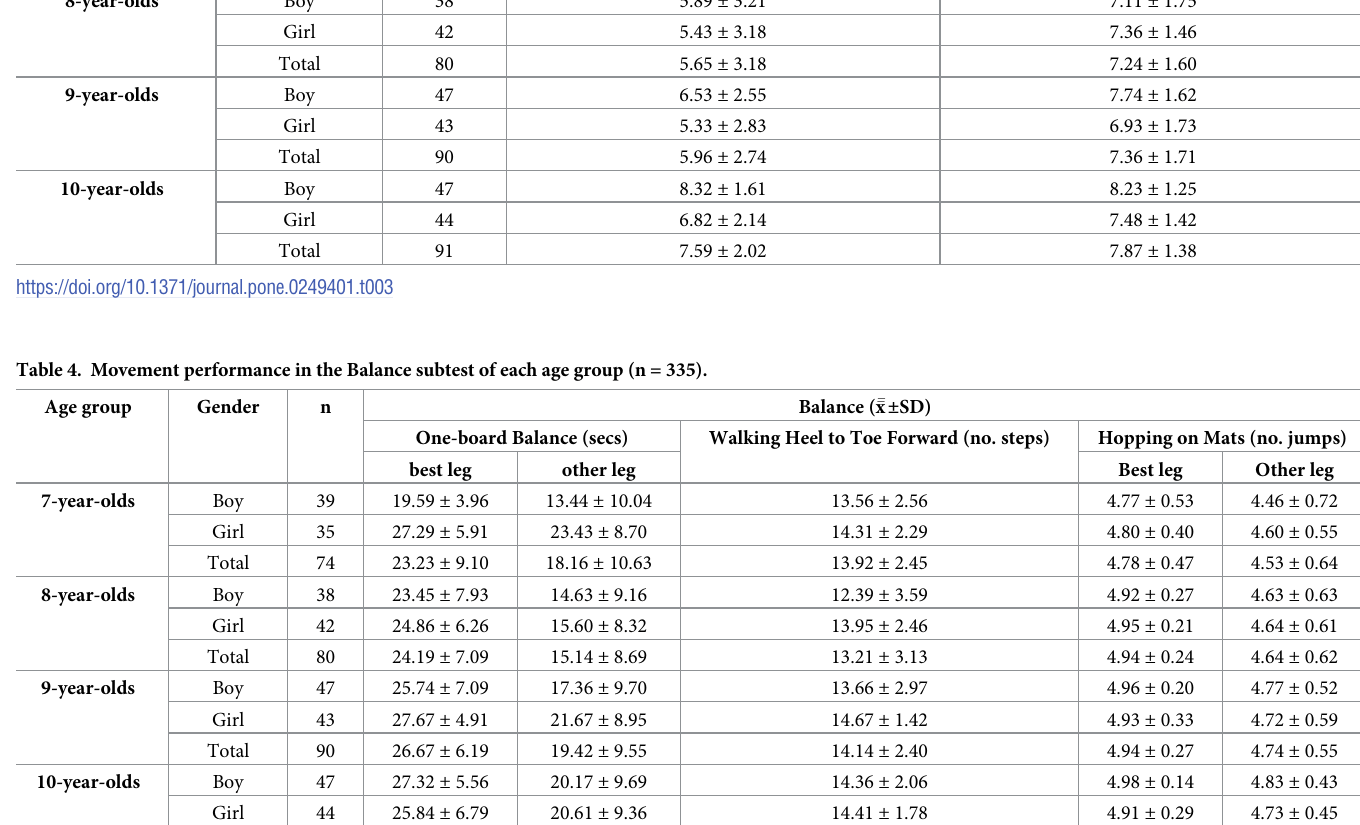
Table 5. Comparison of movement performance between the four groups using one-way ANOVA. Manual Dexterity